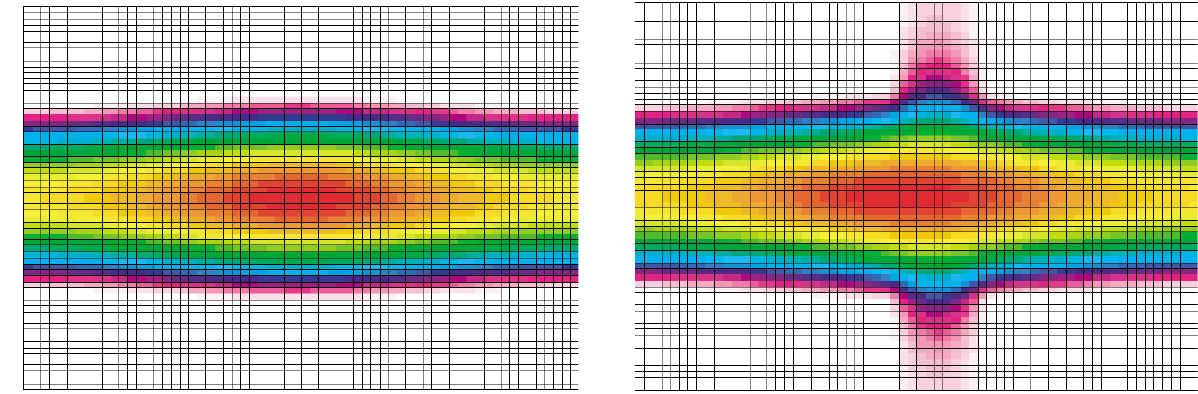
FIG. 6. (Color) Equipotentials in the horizontal plane without and with a coupling